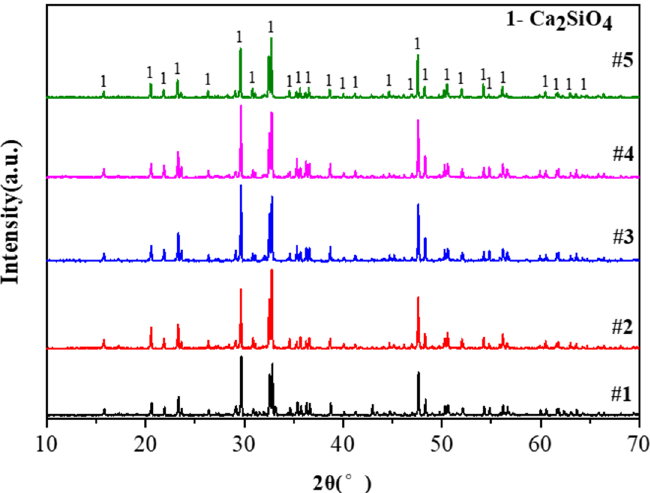
Figure 9. XRD patterns of residue after different pellet reactions.